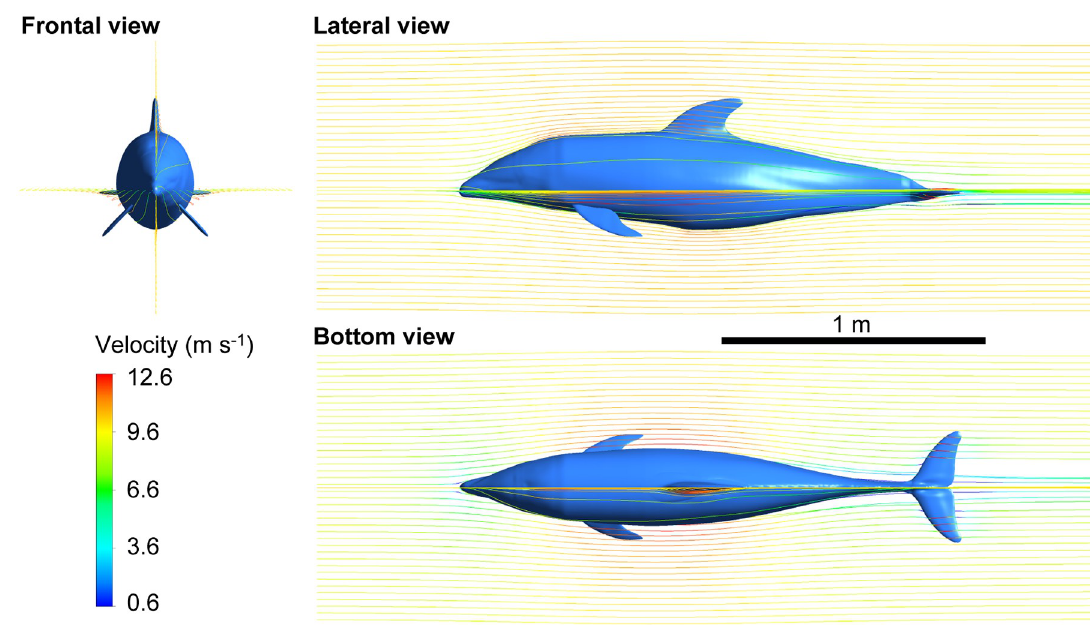
Fig 8. Streamlines starting from vertical and horizontal lines in the CFD calculation with the model of white-beaked dolphin ( Re = 2 × 10 7 , U = 10.2 m s -1 ). The color of the streamlines indicates the velocity magnitude.